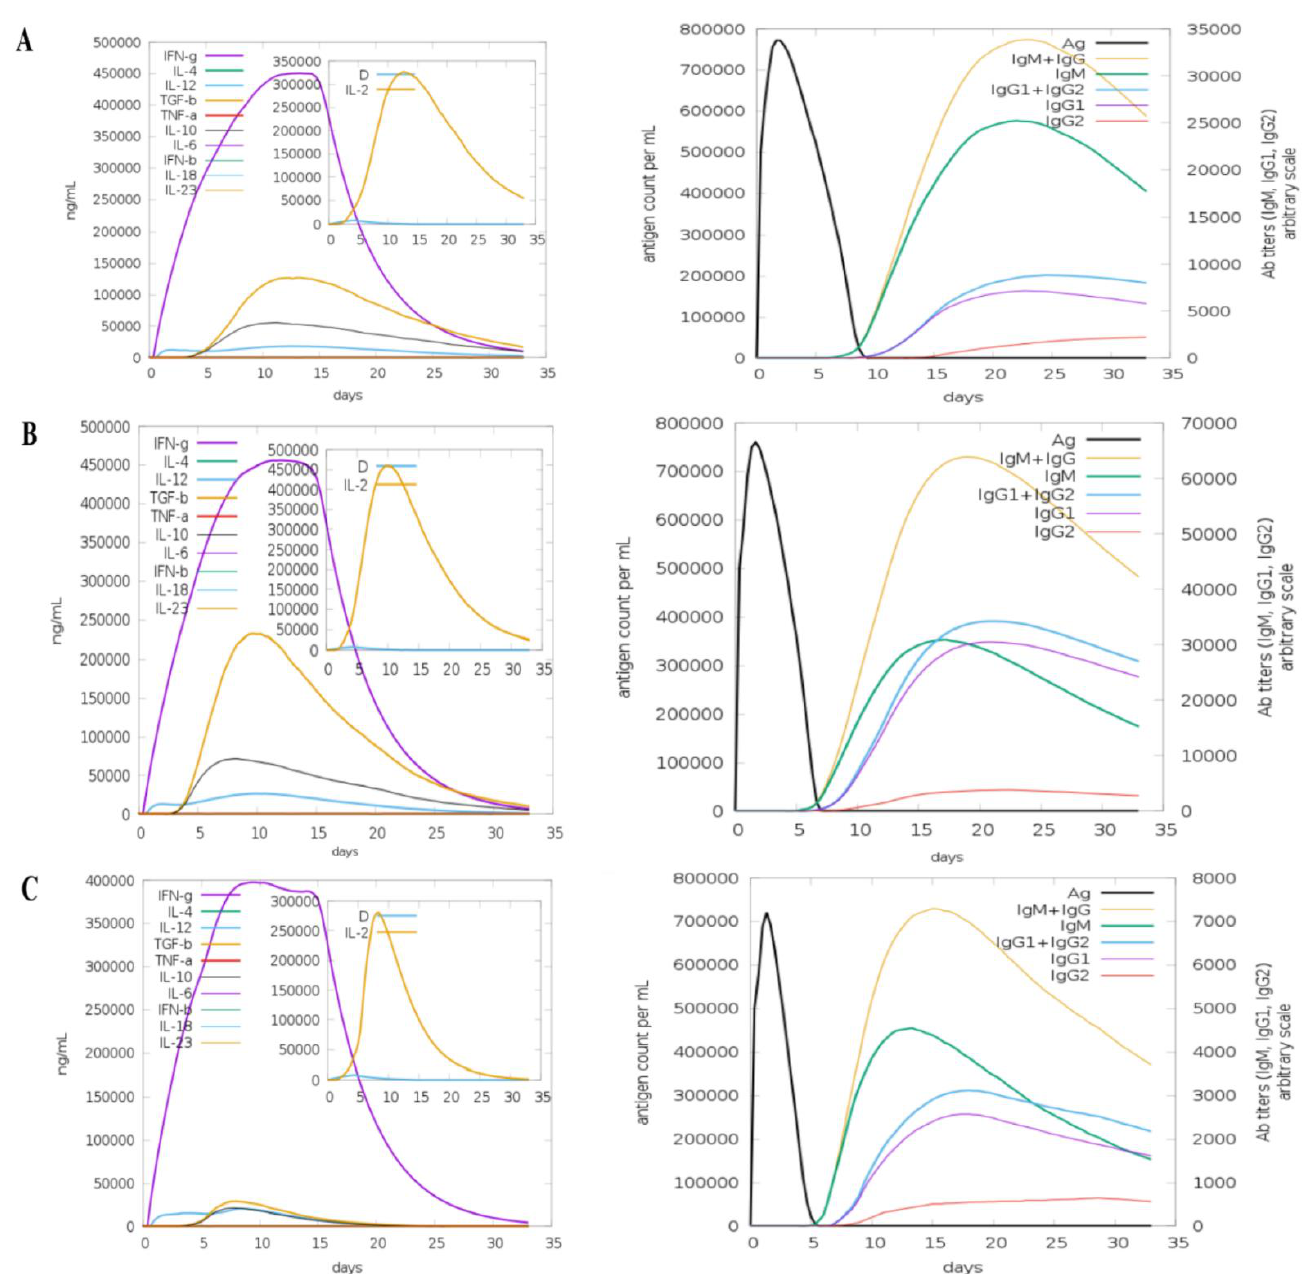
Figure 13. C-Immune Simulation: ( A ) TLR4-agonist, ( B ) β -defensin, and ( C ) 50S ribosomal protein L7/L12 vaccines.